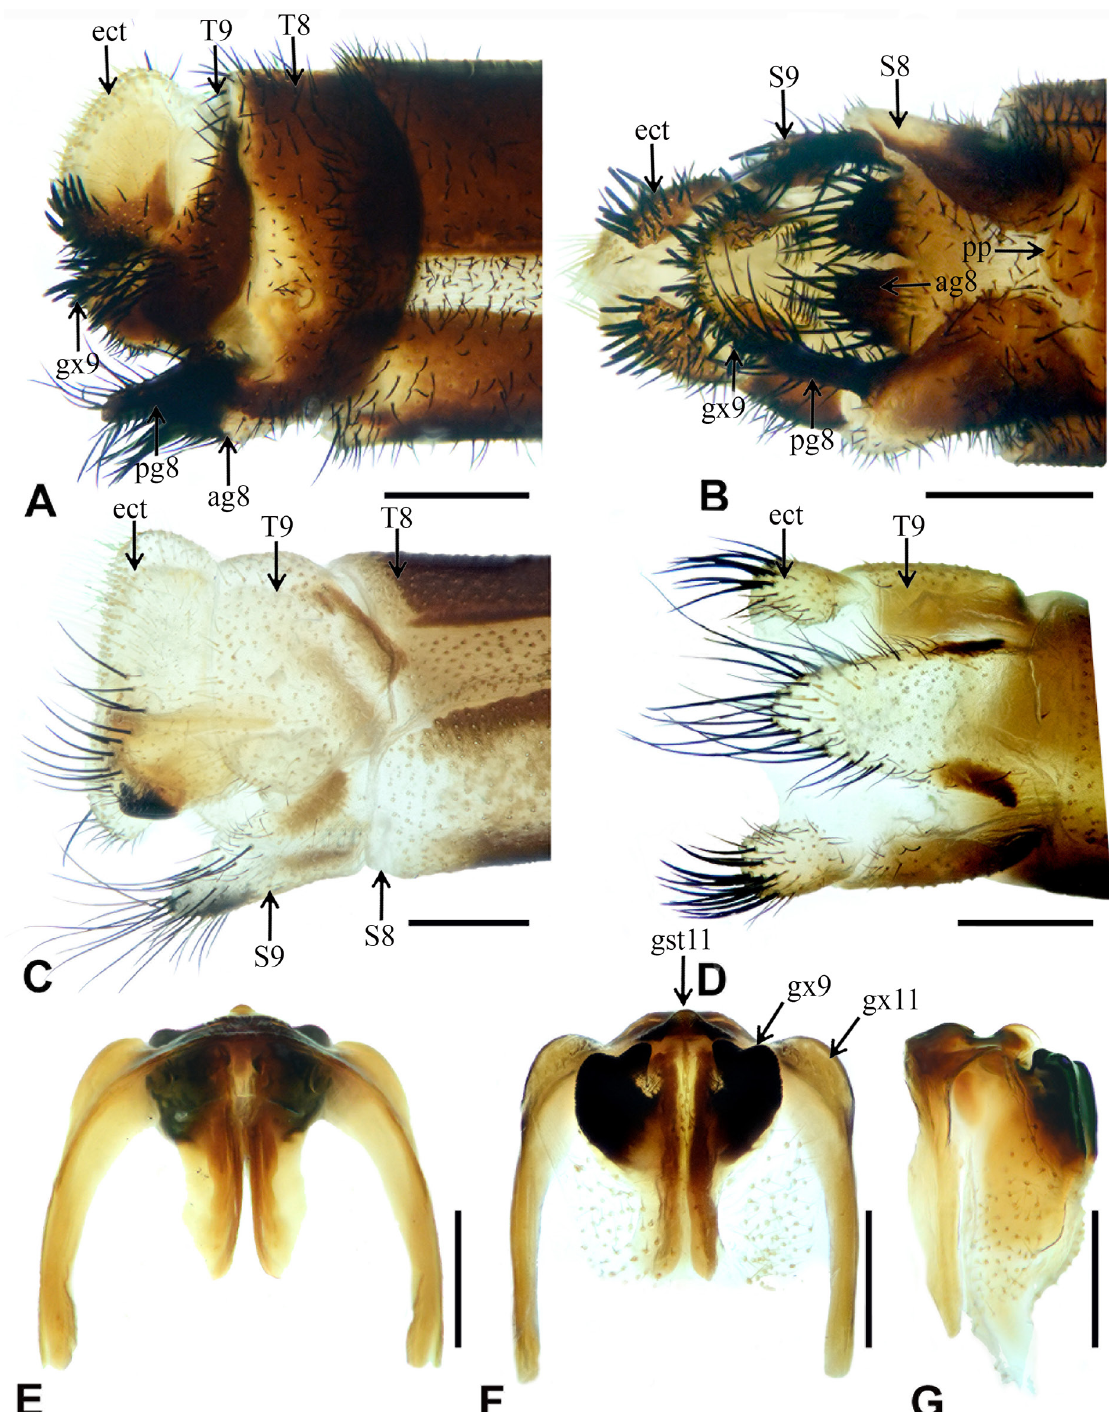
Fig. 19. Myrmeleon trivialis Gerstaecker, 1885. A . Female genitalia, lateral view. B . Same, ventral view. C . Male genitalia, lateral view. D . Same, ventral view. E . Complex of gonocoxites 9 + gonocoxites 11, dorsal view. F . Same, ventral view. G . Same, lateral view. A–B: ♀ (CAUPK000026); C–G: ♂ (CAUPK000025). Abbreviations: ag8 = anterior gonocoxites 8; ect = ectoproct; gst11 = gonostylus 11; gx9 = gonocoxites 9; gx11 = gonocoxites 11; pg8 = posterior gonocoxites 8; pp = pregenital plate; S = sternites; T = tergites. Scale bars = 0.5